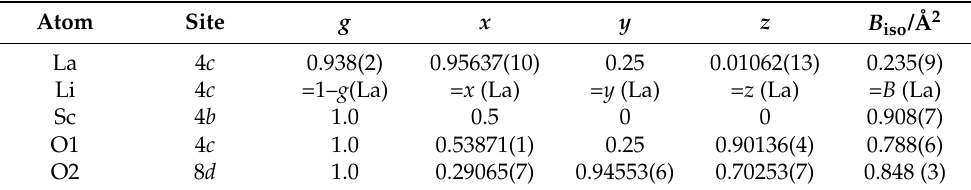
Figure 6. (Color online) Synchrotron Rietveld refinement patterns for (Li 0.45 La 0.85 )ScO 3 ( a ) and (Li 0.45 La 0.78 Ce 0.05 )ScO 3 ( b ) at 298 K. Red: observed intensities; black: calculated intensities; and blue: difference plots. Green vertical markers denote the positions of the Bragg reflections of the space group Pnma (62) (perovskite structure). Table 3. Crystallographic parameters of the synchrotron diffraction data for (Li 0.45 La 0.85 )ScO 3 refined by Rietveld analysis.